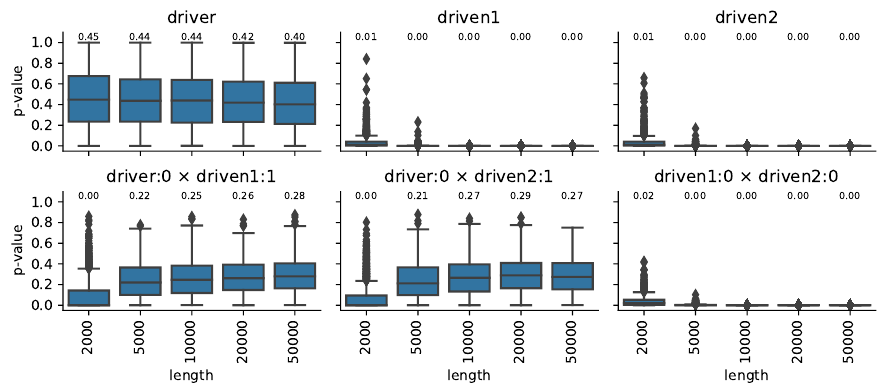
Figure 2. Markov property of Alice (driver) Bob and Barry Driven1,2 ( upper row) and the joints ( lower row) for different sample sizes. After the colon symbol, the lag is indicated, and the stands for the joint of the two series. The number over the boxes indicates the median